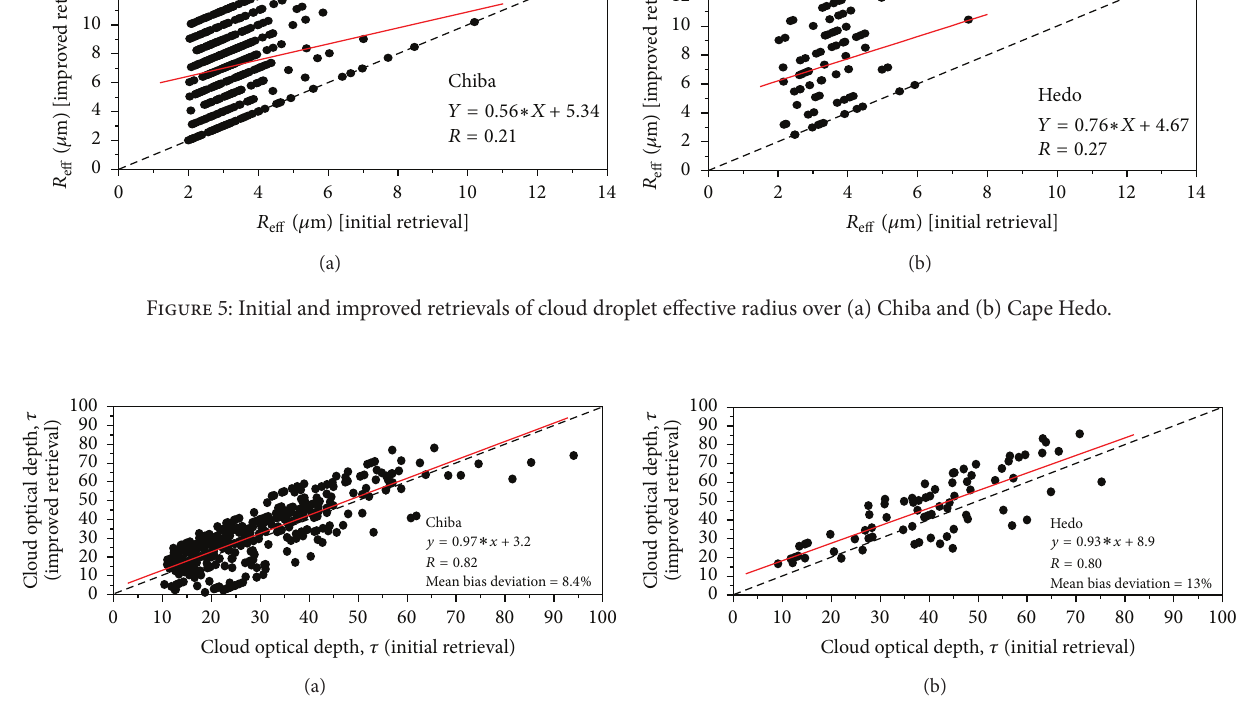
Figure 6: Initial and improved retrievals of cloud optical depth over (a) Chiba and (b) Cape